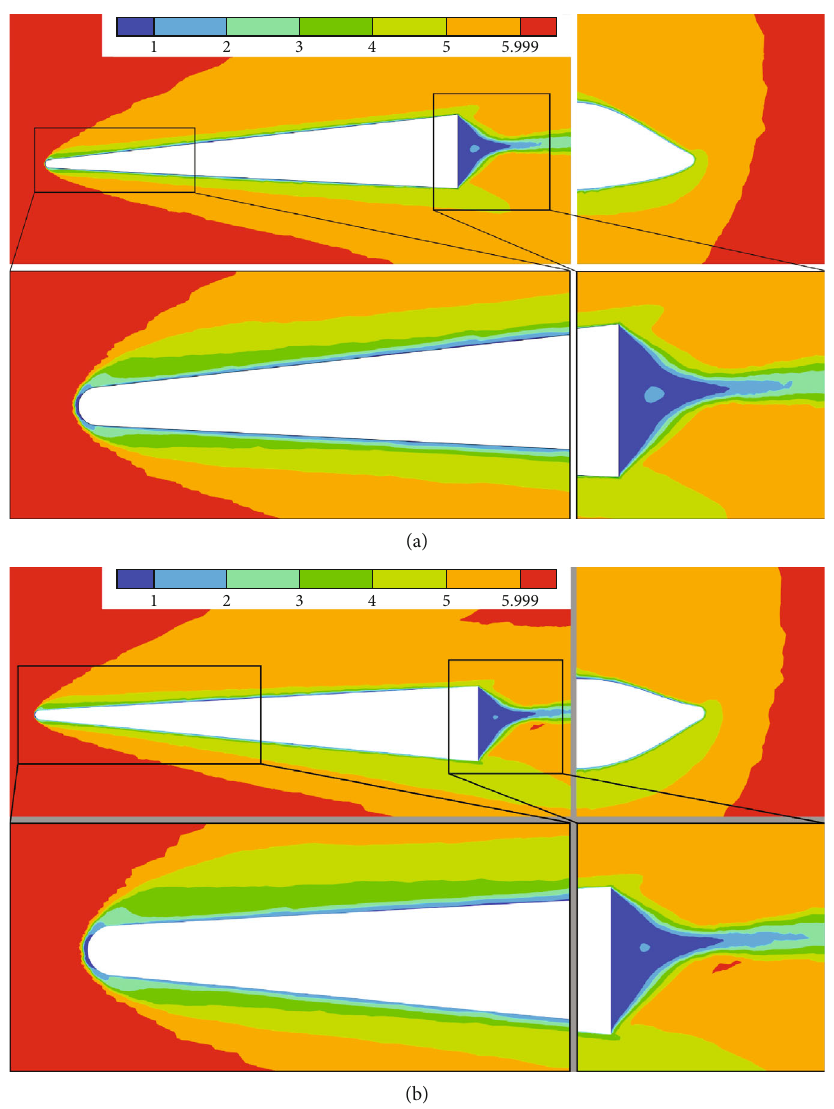
Figure 13: Mach number distribution on the symmetric plane: (a) the baseline and (b) the